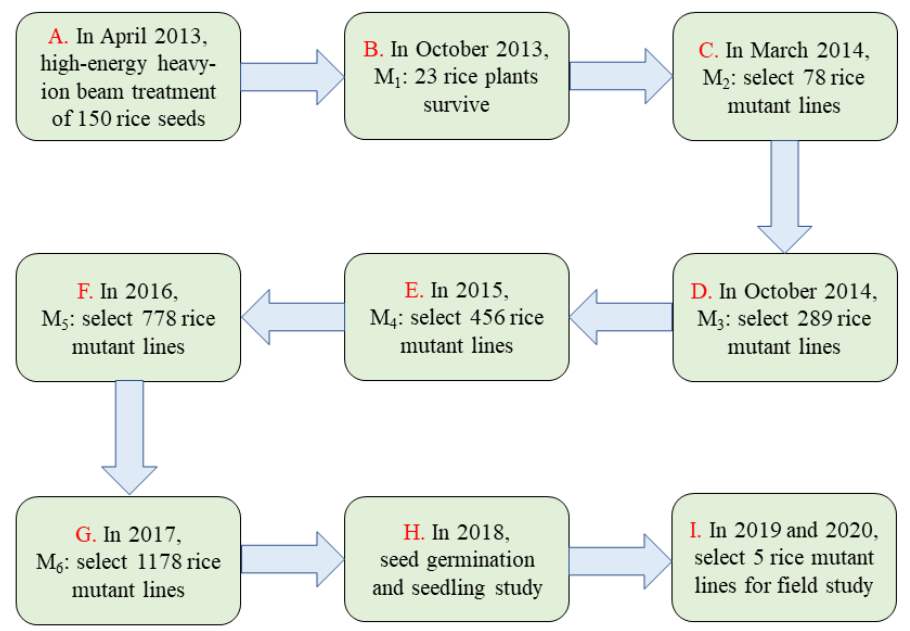
Figure 1. Development of the heavy-ion beam mutagenesis rice population. Schematic diagram of the steps that were taken to create ( A ), breed ( B – G ), and test ( H – I ) the mutant lines. M1–M6 repre- sent the mutant